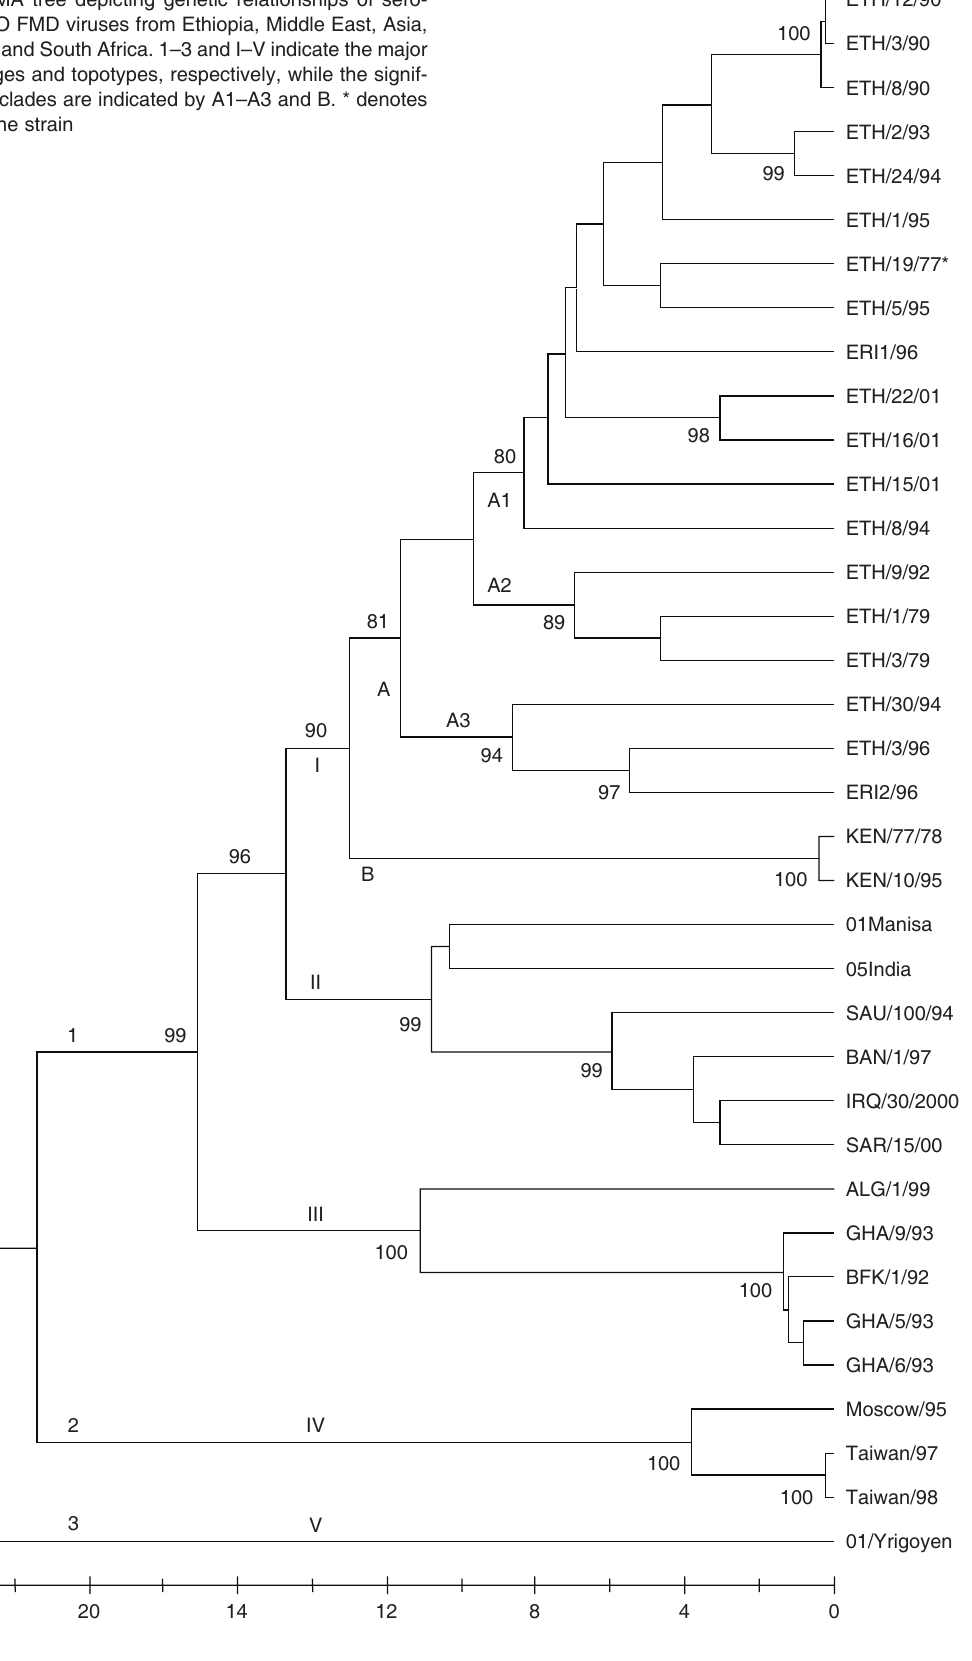
FIG. 1 UPGMA tree depicting genetic relationships of sero- type O FMD viruses from Ethiopia, Middle East, Asia, West and South Africa. 1–3 and I–V indicate the major lineages and topotypes, respectively, while the signif- icant clades are indicated by A1–A3 and B. * denotes vaccine